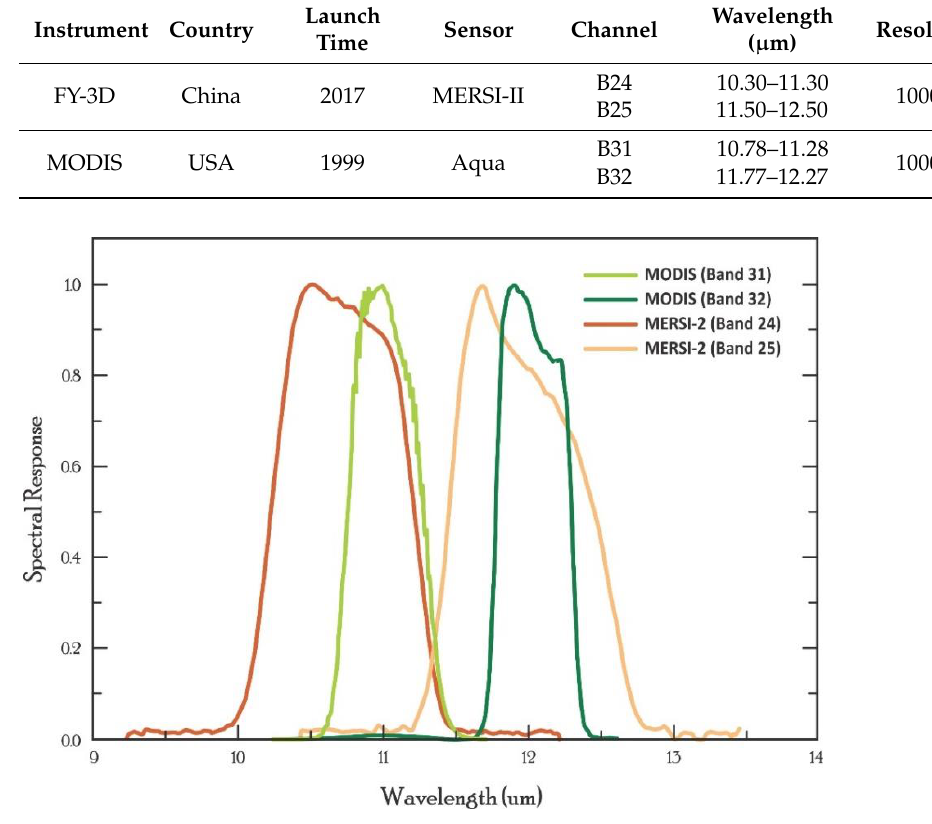
Figure 2. Spectral response functions of the MERSI-II and MODIS TIR channels. Table 1. FY-3D sensor characteristics that correspond to the MODIS TIR Bands are commonly used for retrieving land surface temperature.